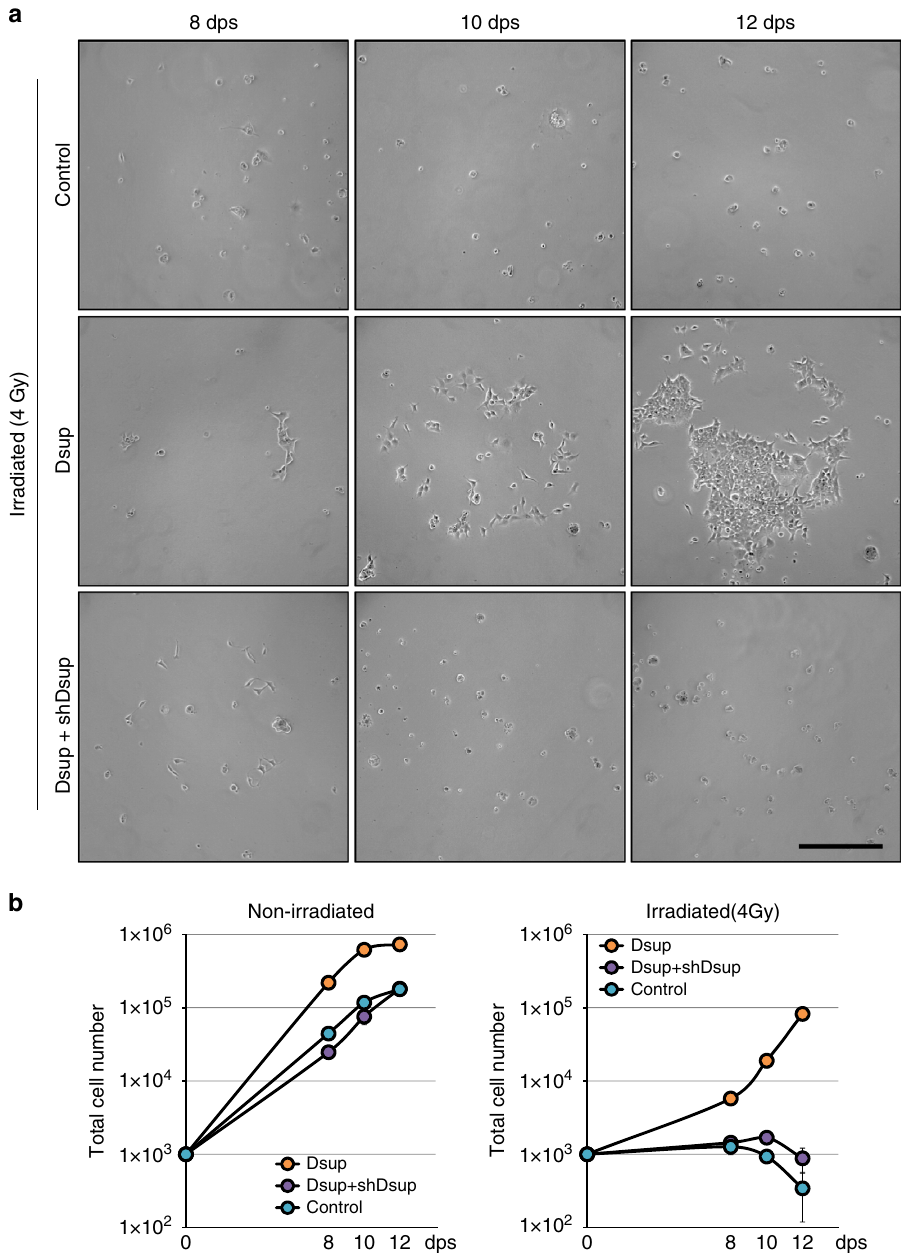
Figure 6 | Improved viability and proliferative ability of Dsup-expressing cells after irradiation. ( a ) Representative microscopic images with phase contrast at 8, 10 and 12dps, of untransfected HEK293 cells (Control), Dsup-expressing cells (Dsup) and Dsup -knockdown cells (Dsup þ shDsup) irradiated with 4Gy X-ray at 1 dps. Scale bar, 200 m m. ( b ) Comparison of growth curves of untransfected cells (Control), Dsup-expressing cells (Dsup) and Dsup-knockdown cells (Dsup þ shDsup) in non-irradiated and irradiated conditions. Values represent mean ±